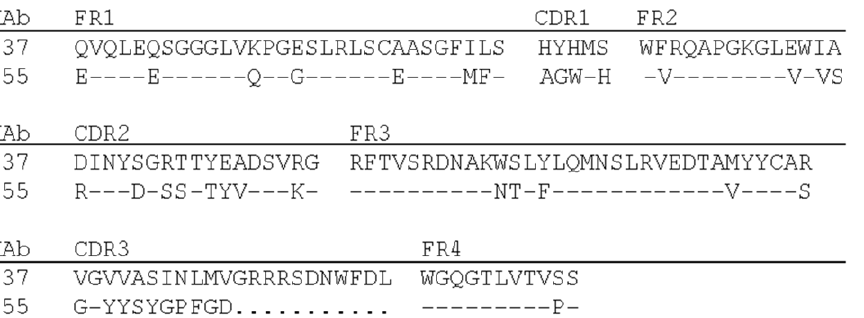
Figure 1. Amino acid sequences of the V H regions of # 37 and # 55. Residues identical to # 37 sequences are indicated by a dash. Dots indicate gaps compared with the sequence of # 37. MAb, monoclonal antibody; FR, framework regions; CDR, complementarity-determining regions.